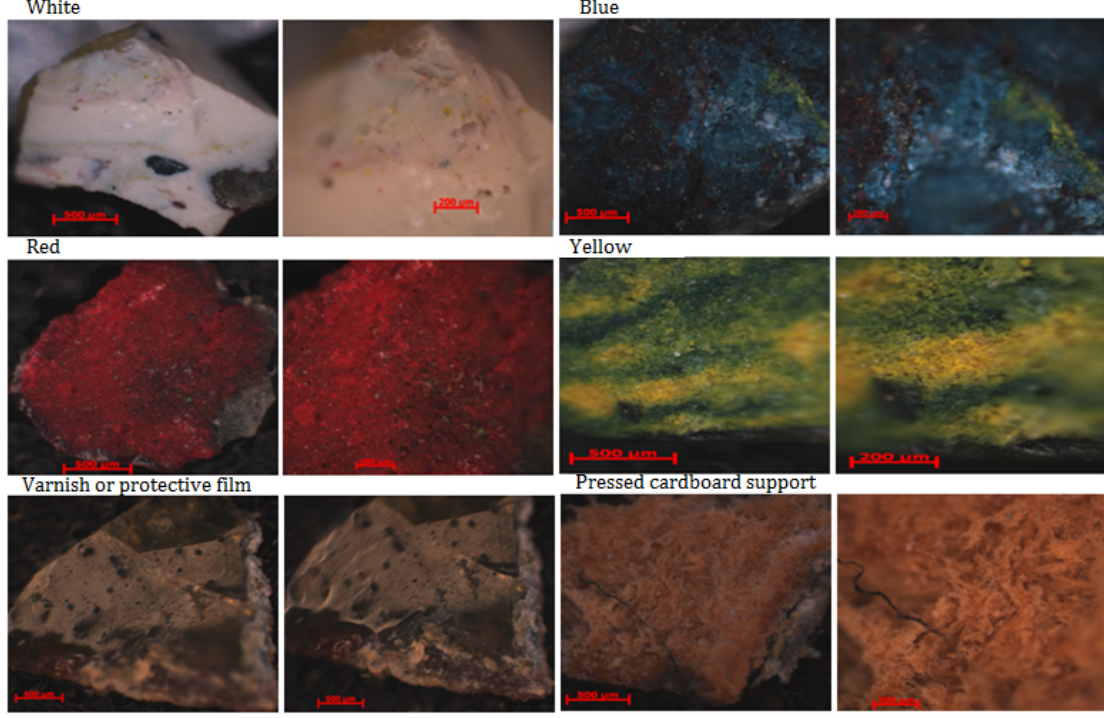
Figure 15. OM microphotographs of some components of the painting materials (50 × and 100 ×).